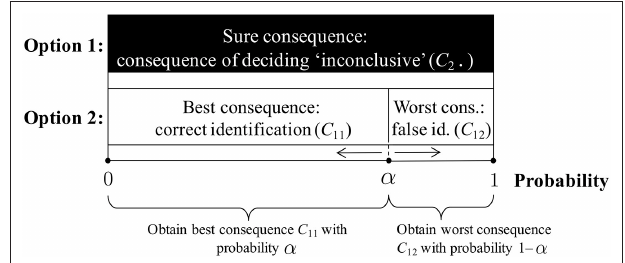
FIGURE 2 | Illustration of the utility elicitation procedure. Option 1 involves having the consequence of deciding “inconclusive” for sure. Option 2 involves having the best consequence (correct identification, C 11 ) with probability α and the worst consequence (false identification, C 12 ) with probability 1 − α . The procedure asks one to specify the probability that would make one indifferent between option 1 and option 2. This value then corresponds to the utility of the consequence for which a value needs to be elicited (here, the consequence of deciding “inconclusive,” C 2 · ). Note that the particular value α shown in the figure is an example. The value α can vary in both directions toward 0 and 1, as illustrated by the edges ← and →